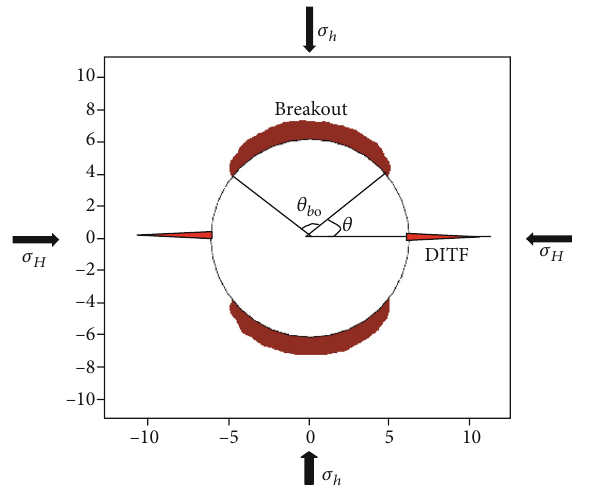
Figure 7: Schematic fi gure showing wellbore tensile failure (drilling-induced tensile fractures, DITF in the fi gure) and shear failure (wellbore breakouts) in a vertical borehole cross